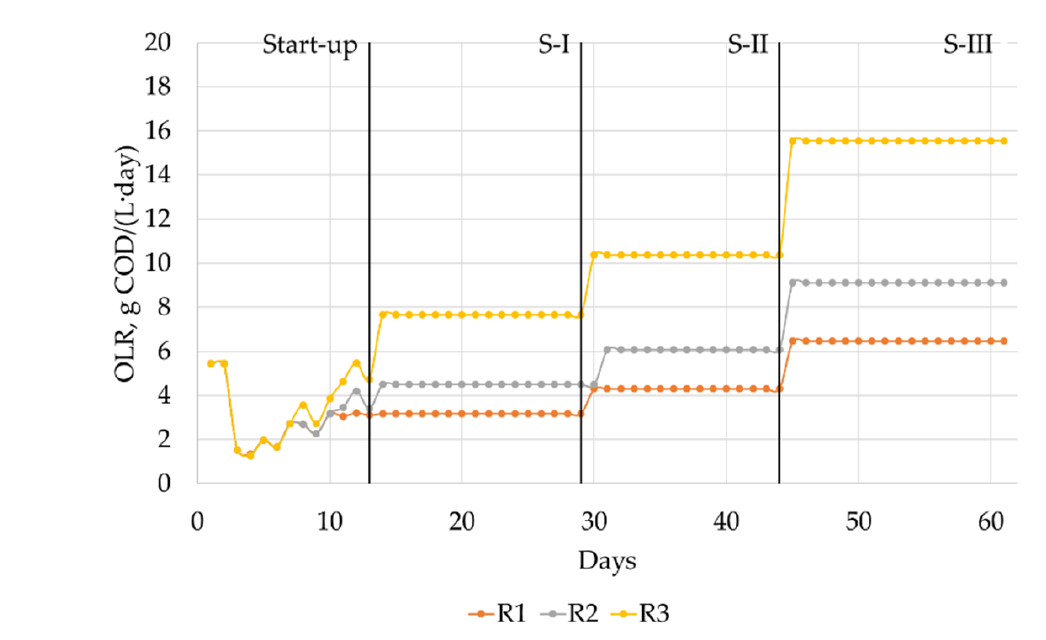
Figure 2. OLR values during the experiment. Table 2. OLR values depending on the DR and HRT.